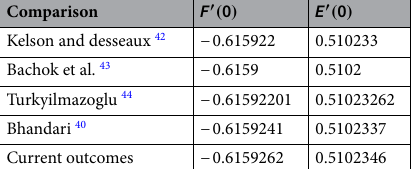
Table 3. A similar solution is compared to earlier theoretical models m 1 = ϕ 1 = 0 .